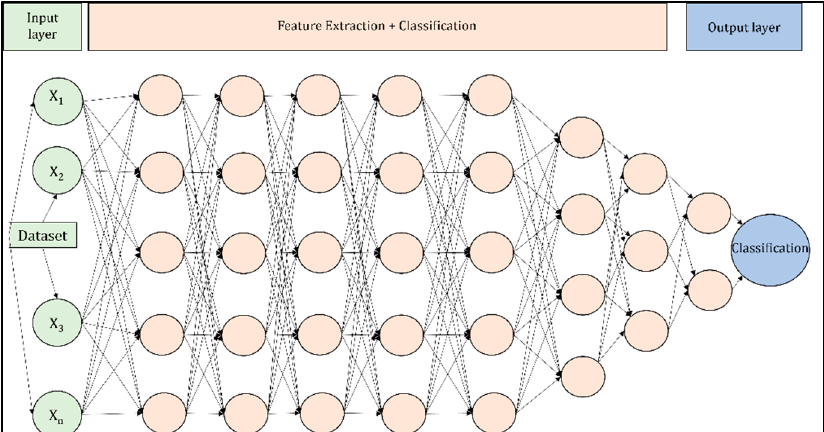
Figure 2. Deep learning model design.